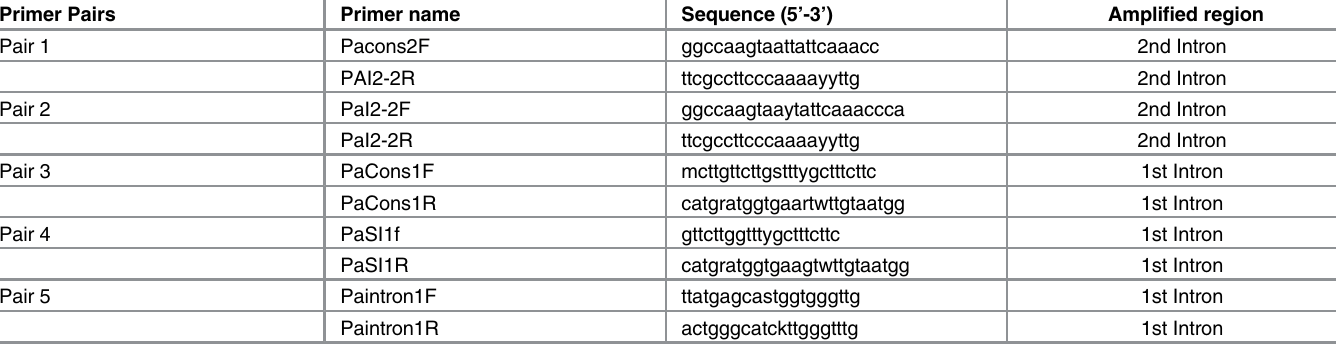
Table 2. Specific primers developed for amplification of S-alleles in P . africana . Pattern indicates primer combinations. Primer